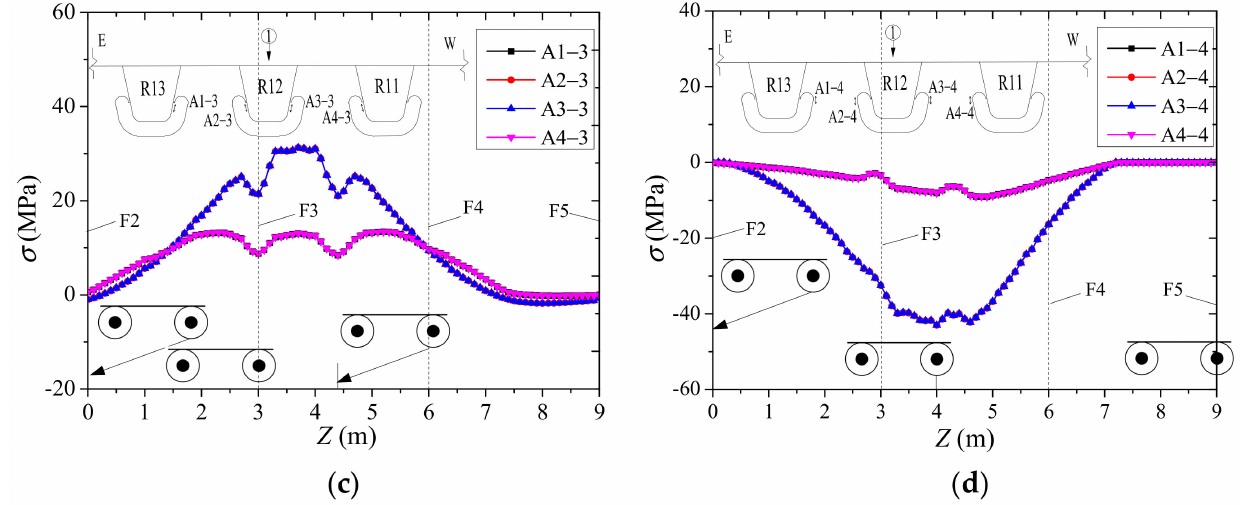
Figure 16. Calculated stress of four details under LC1. ( a ) RF-R; ( b ) RF-F; ( c ) RF-W; ( d ) Cutout.